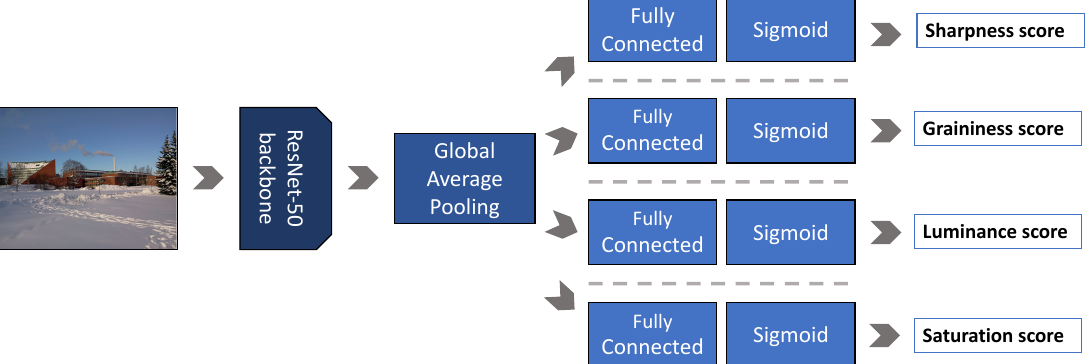
Figure 2. Definition of the Extractor-Q. Given an image of any size the Extractor-Q simultaneously estimates the scores for four quality attributes, namely sharpness, graininess, lightness, and color saturation. It consists of a ResNet-50 followed by a Global Average Pooling (GAP) and a stack of fully connected (FC) + sigmoid layers for each